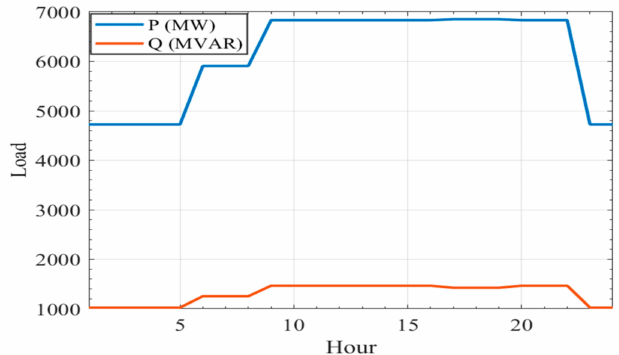
Figure 6. Hourly load values of the 118-bus